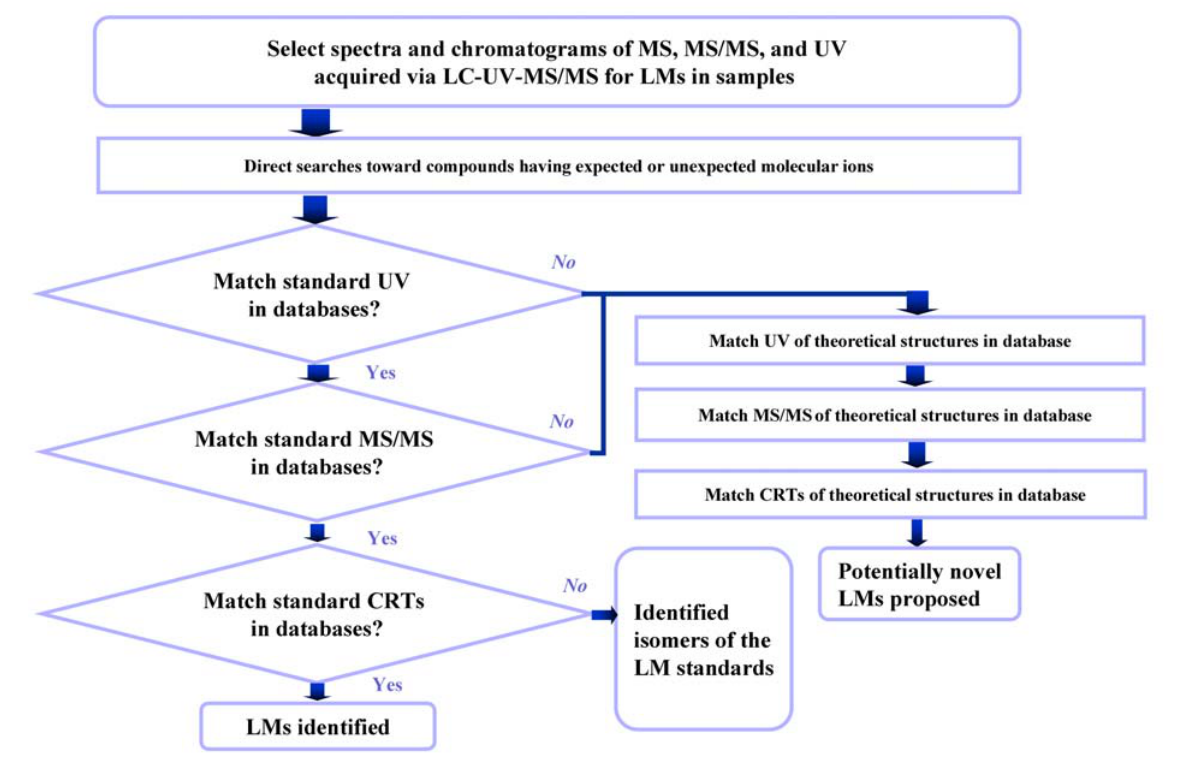
SCHEME 3. Logic diagram for developing LC-UV-MS/MS-based mediator databases and search algorithms for lipidomic analyses of PUFA-derived